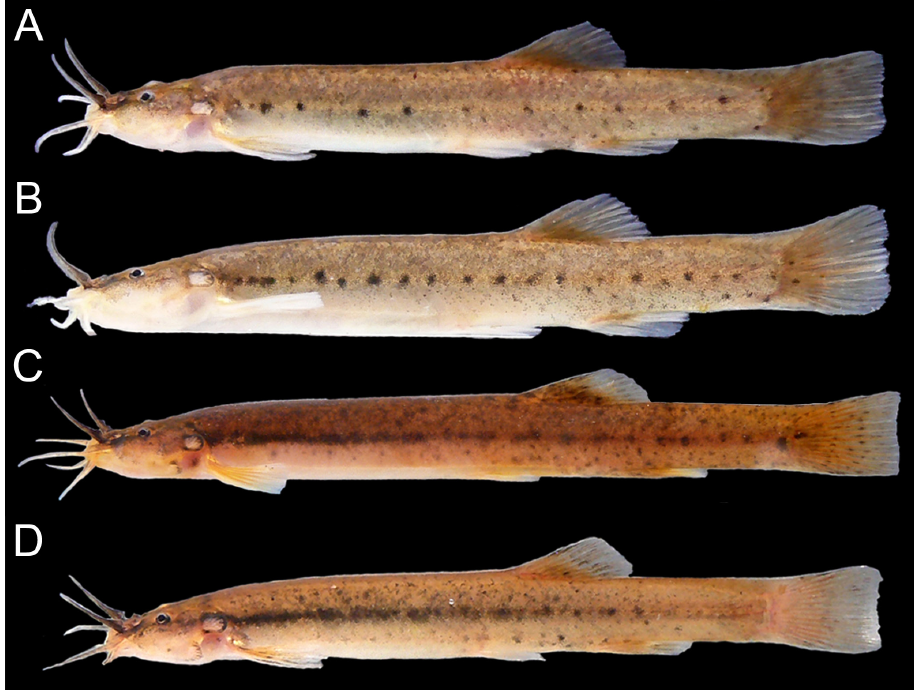
FIGURE 7 | Coloration pattern of Cambeva species. ( A, B ). Cambeva guaraquessaba , UFRGS 24554, 37.0 and 36.9 mm SL, respectively, tributary of Guaraqueçaba River basin, Paranaguá Bay. C–D . Cambeva tupinamba , UFRGS 24550, 63.0 mm SL and 39.4 mm SL, Betari River, Ribeira de Iguape River